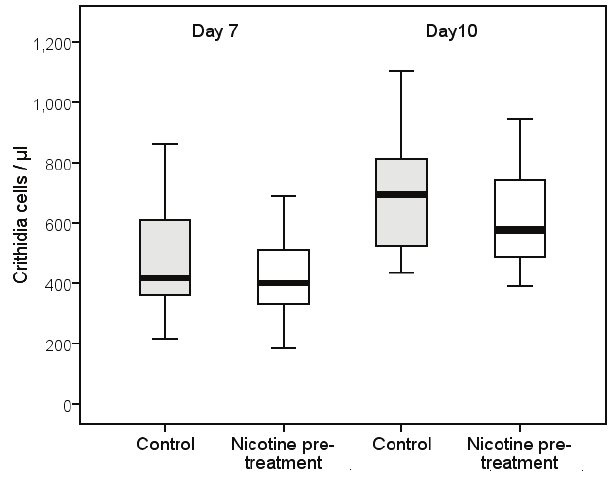
Figure 1. Intensity of C. bombi infections in bumblebees that received either a nicotine diet (Experimental bees, n = 20) or a sucrose only diet (Control bees, n = 20). Faeces were checked after 7 days and 10 days post inoculation. Box plots show medians, 25 th and 75 th percentiles (** P < 0.001; * P = 0.001).